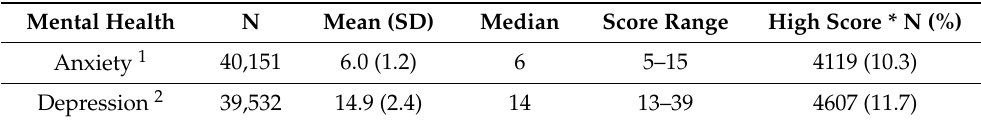
Table 2. Number of participants in the analyses and child mental health outcomes at 8 years. The symptoms scales are ranged from low score reflecting few symptoms and high score reflecting more symptoms.